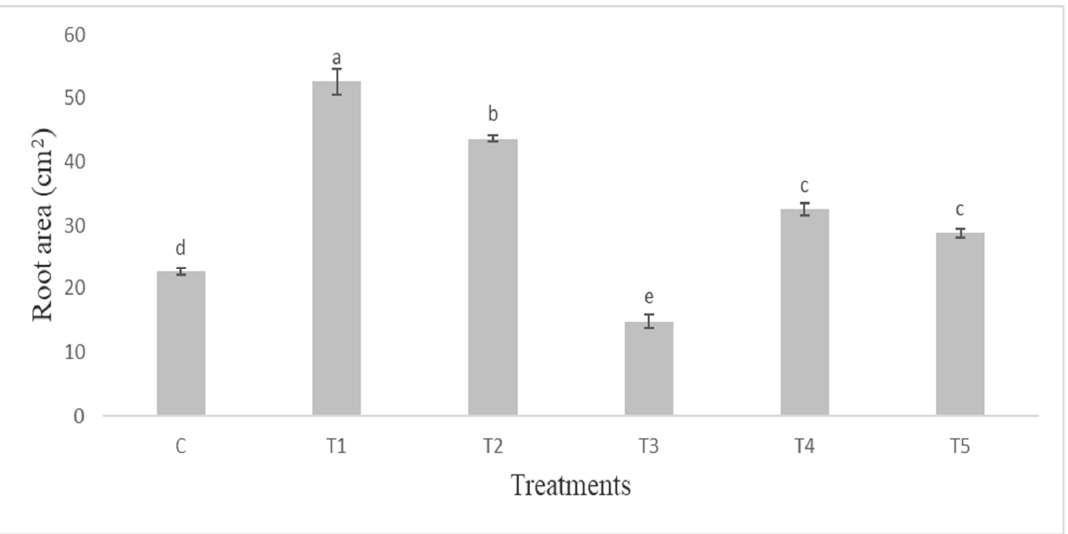
Figure 2. Root area (cm 2 ) of tomato plant infested with S. litura and under control condition. Data are means of four replicates along with standard error bars. Different letters are indicating significant differences ( p < 0.05) among treatments.